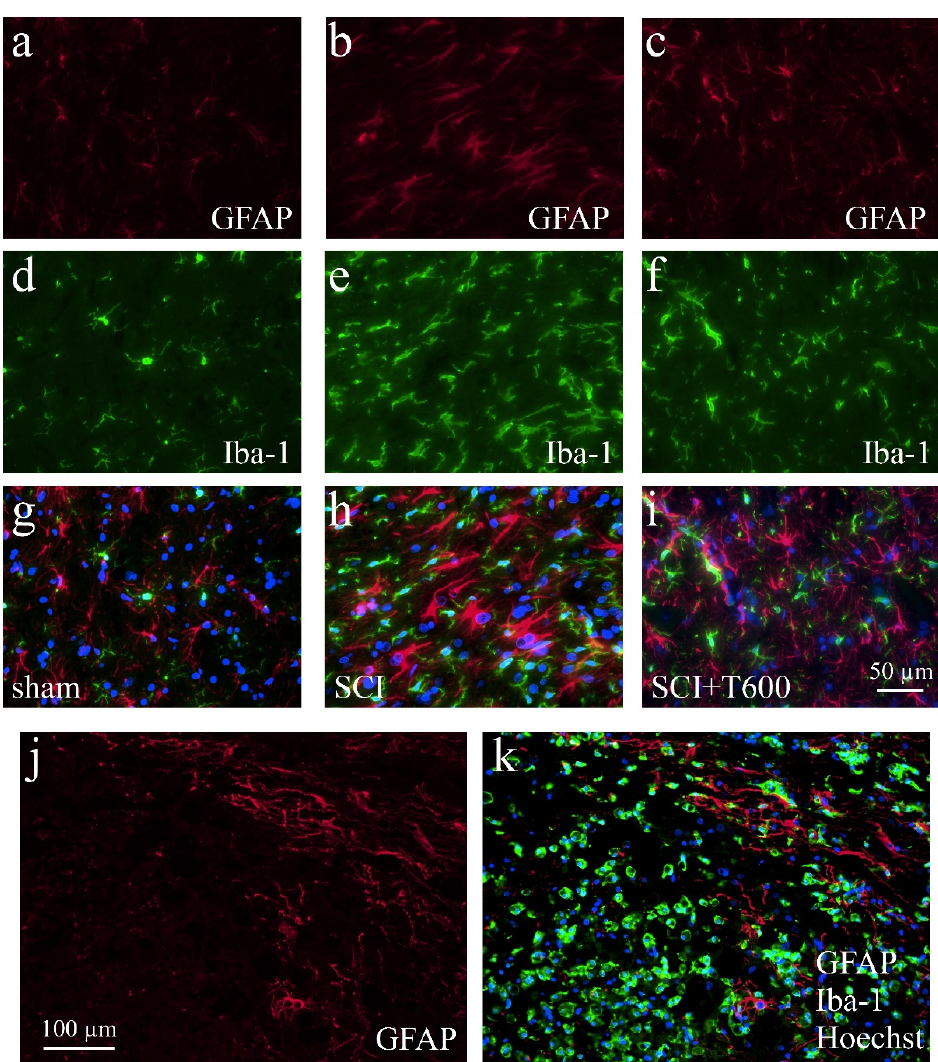
Figure 8. Activation of microglia and astrocytes after SCI. The IF photographs show examples of grey matter at 4 dpo and a distance of ca. 0.4 mm from the lesion center, which were double-stained for astrocytes (GFAP; a – c ) and microglia (Iba-1; d – f ). Photographs were superimposed with additional nuclear staining (Hoechst 33342; g – i ). ( a , d , g ) Section from laminectomy-operated animal. ( b , e , h ) SCI with saline injection; ( c , f , i ) SCI treated with two injections of TUDCA 300 mg/kg. ( j , k ) At 4 dpo under all SCI treatment conditions, astrocytes showed increased GFAP IR but a glial scar had not yet developed. Scale = 50 µm in ( i ) (for ( a – i ), 40× objective) and 100 µm in ( j ) (for ( j – k ), 20× objective). Macrophages fill the lesion center.